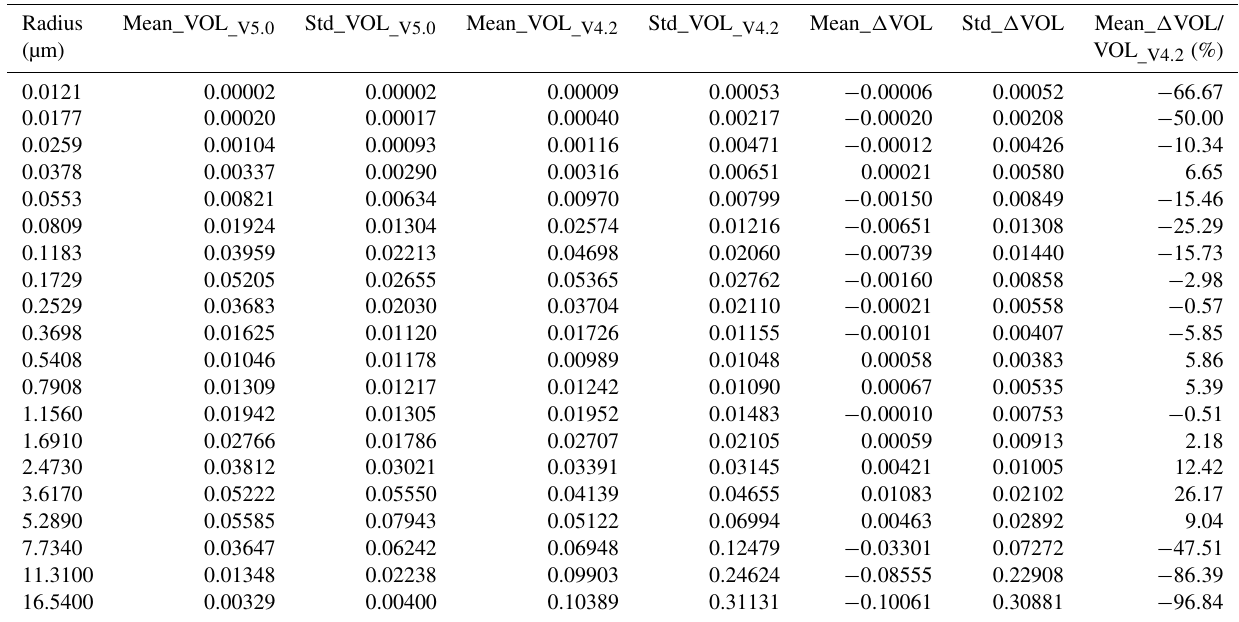
Figure 3. Retrieved monthly volume size distribution by SKYRAD V4.2 (dotted lines) and V5.0 (solid lines) for Qionghai (blue lines) and Yucheng (red lines) during February 2013 to December 2015. Table 1. Averaged volume size distribution in each bin and the differences between the two versions at the Qionghai site during February 2013 to December